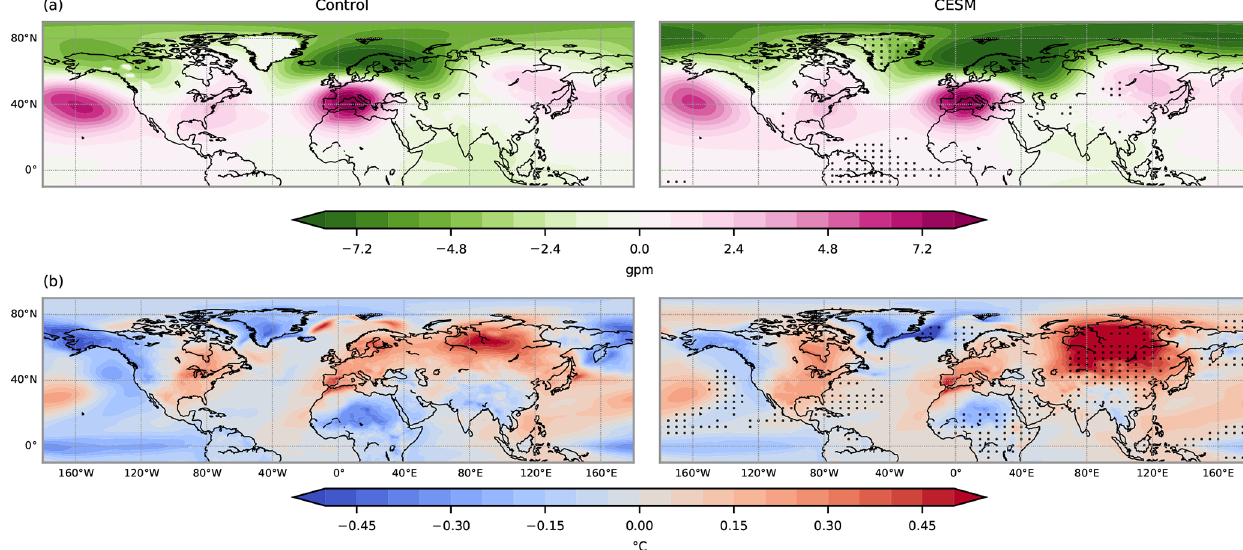
Figure 8. (a) Mean geopotential height anomaly at 850hPa and (b) mean surface temperature anomaly for the control (left) and transient (right) simulations during Mediterranean droughts in 850–1849CE. Black dots on the composites of the transient simulation indicate the regions where the distributions between the control and transient simulations are statistically different from each other at the 5% confidence level according to the Mann–Whitney U